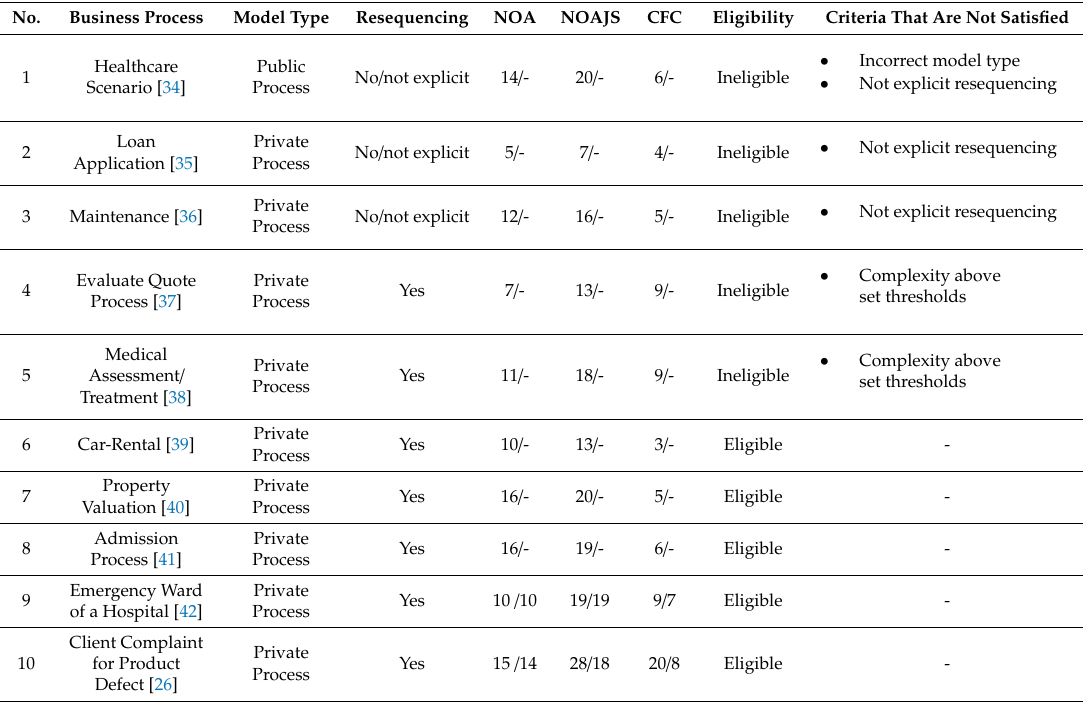
Table 2. BPMN examples in relevant research